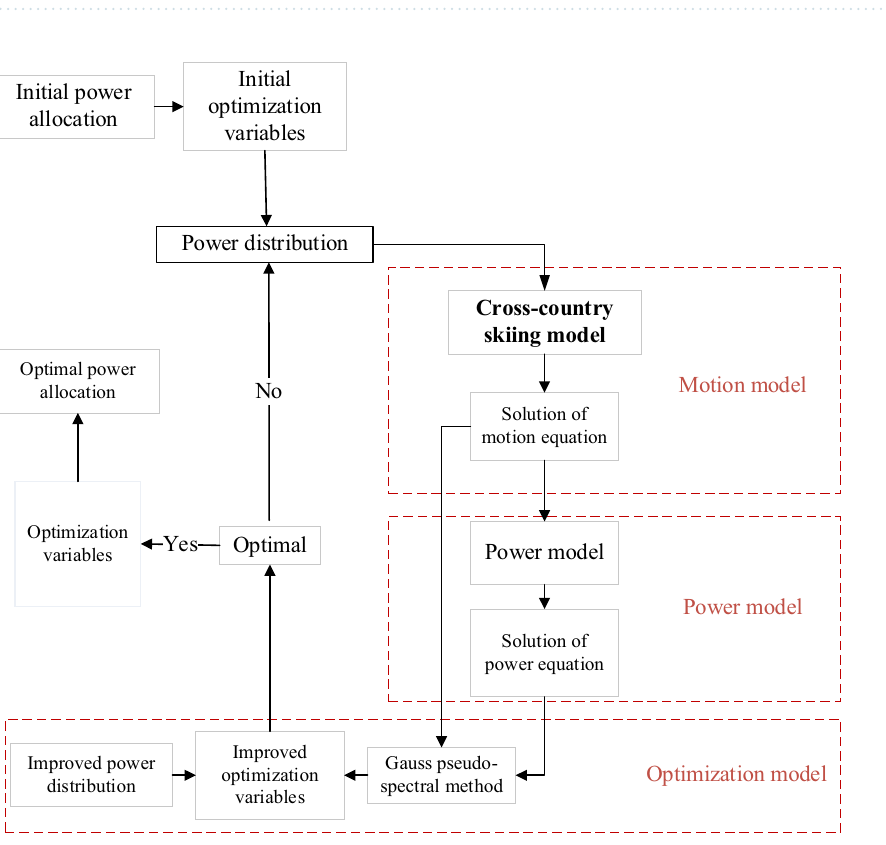
Figure 6. Pacing strategy optimization flow chart 15